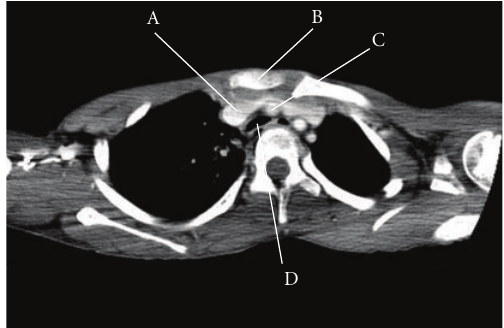
Figure 2: Chest computed tomography. Computed tomogram before the operation shows extrinsic compression of the trachea by the innominate artery. (A) Superior vena cava; (B) manubrium; (C) innominate artery; (D) trachea.